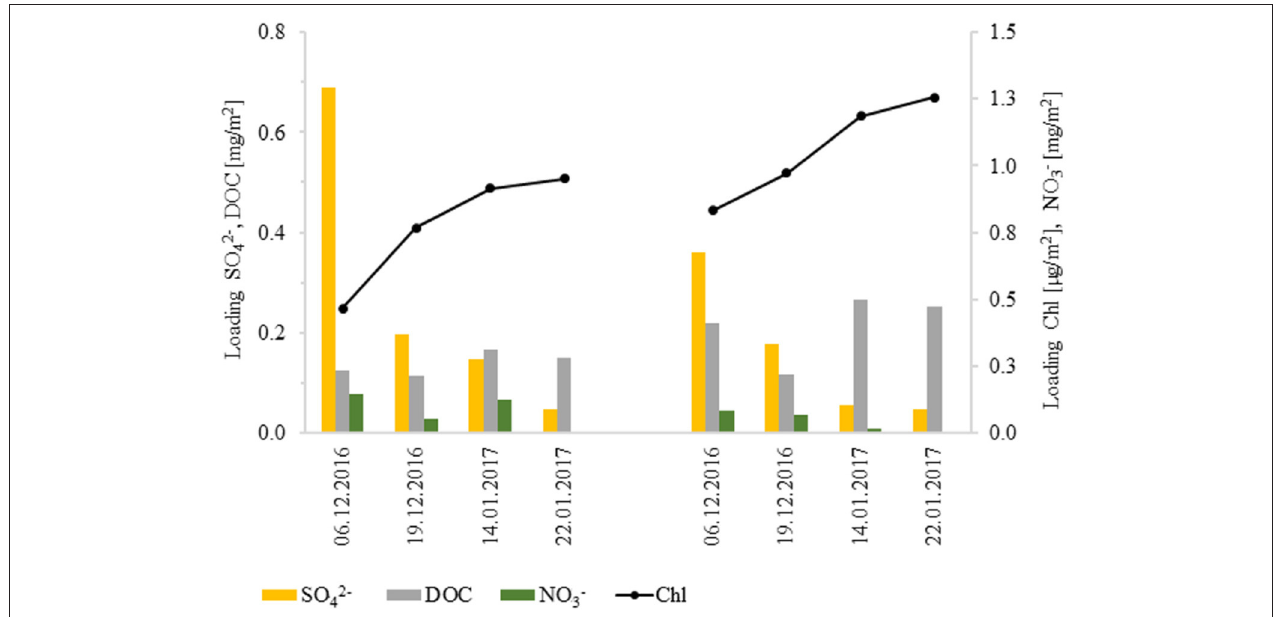
FIGURE 11 | The comparison of snowpack loadings of selected ions, DOC and in-vivo chlorophyll at both the Beach (left) and the Inland (right) sites.